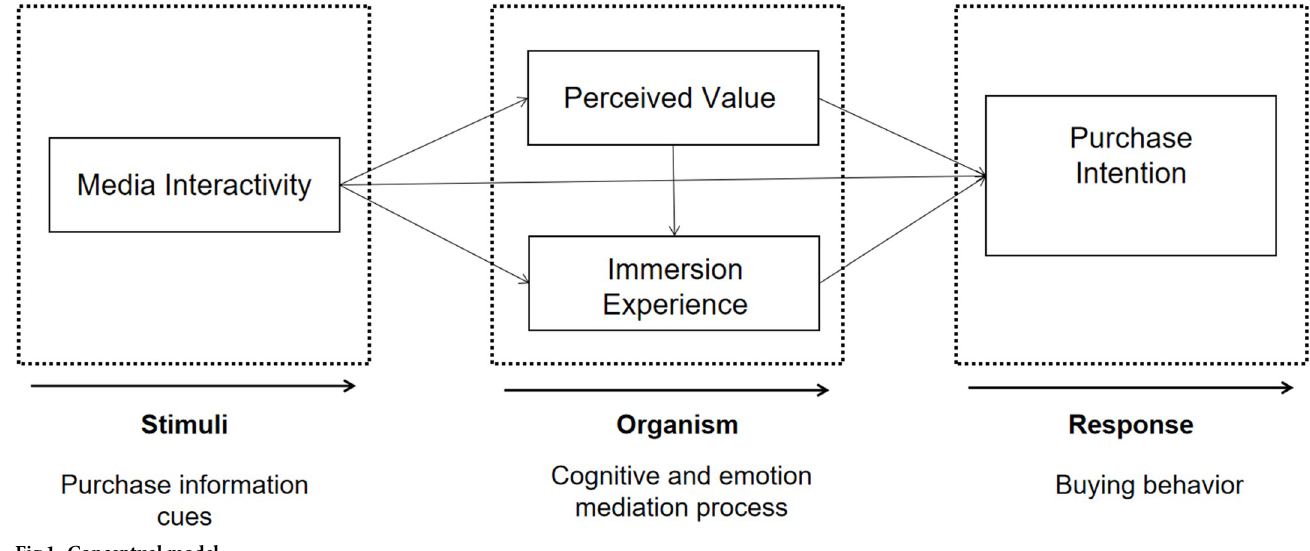
Fig 1. Conceptual